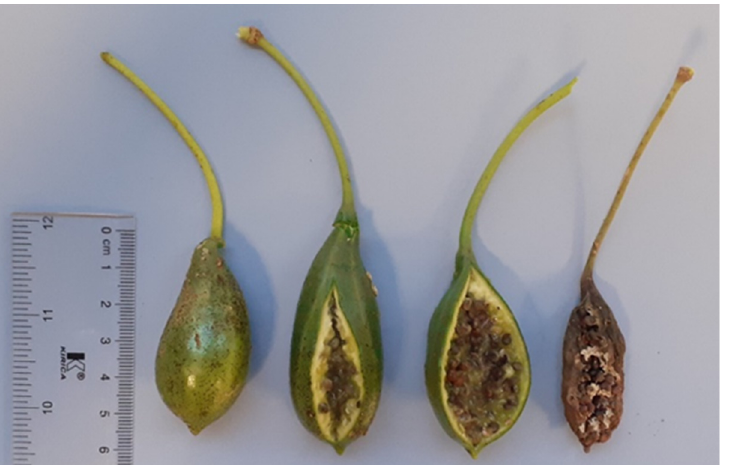
Figure 1. Fruit types from which the seeds were extracted according to their maturation stage. From left to right: ripe fruits collected before dehiscence (type I; 42 days after anthesis (daa)), ripe fruits immediately after dehiscence (type II; 45 daa), overripe dehiscent fruits before they deteriorate due to pulp degradation (type III; 48 daa), and deteriorated fruits with dry pulp (type IV; 55 daa).